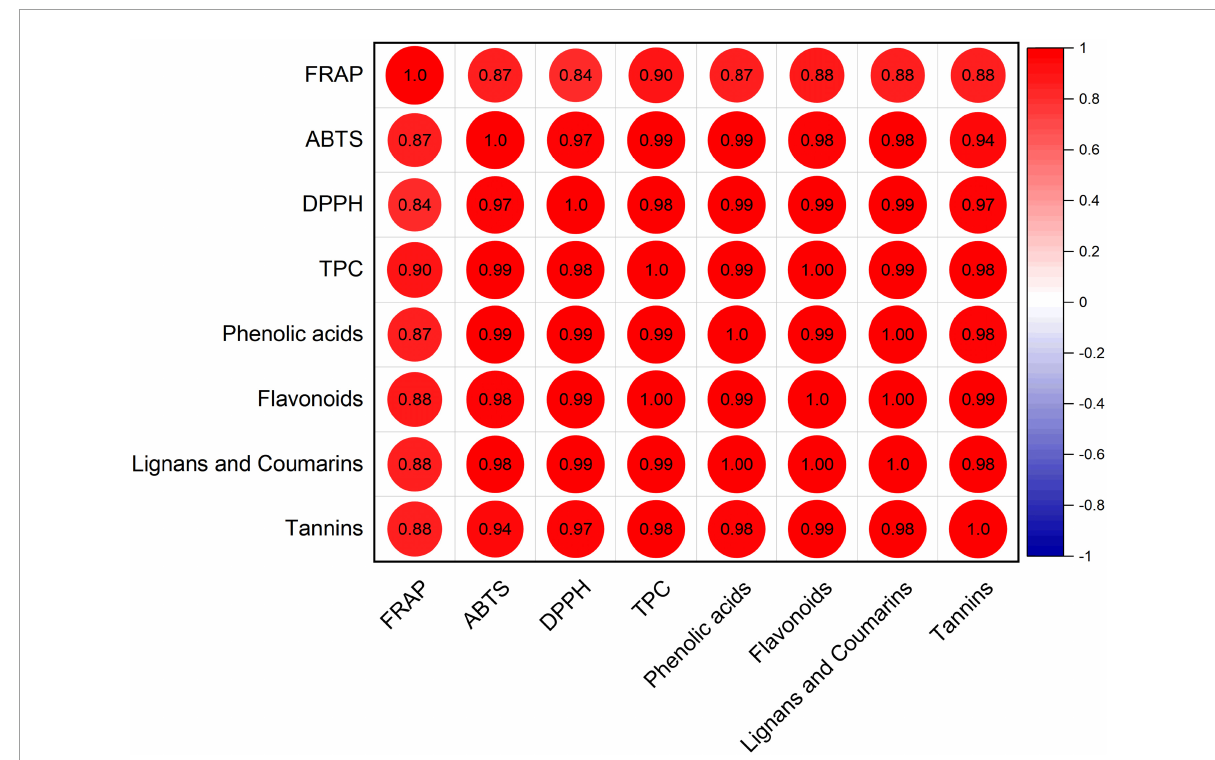
FIGURE6 Correlation analysis among antioxidant capacity, TPC, and phenolic